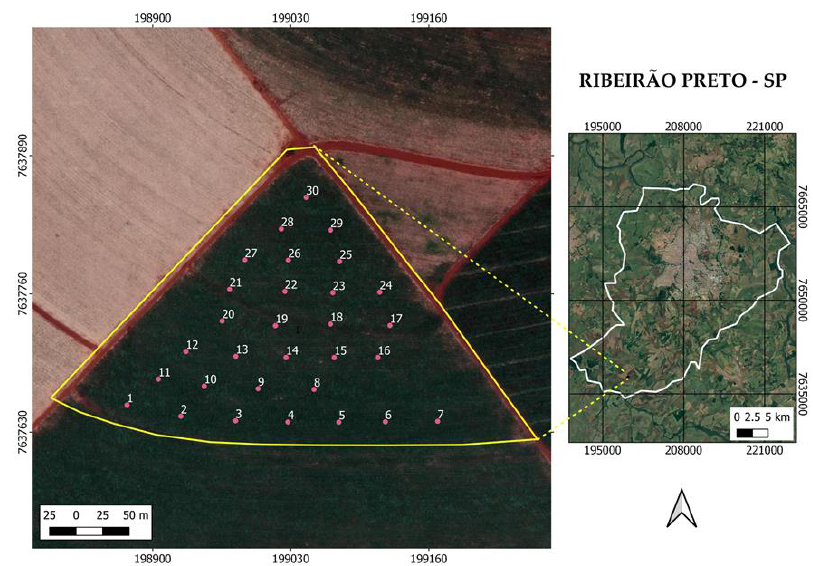
Figure 1. Experimental field located in Ribeirão Preto, São Paulo, Brazil.